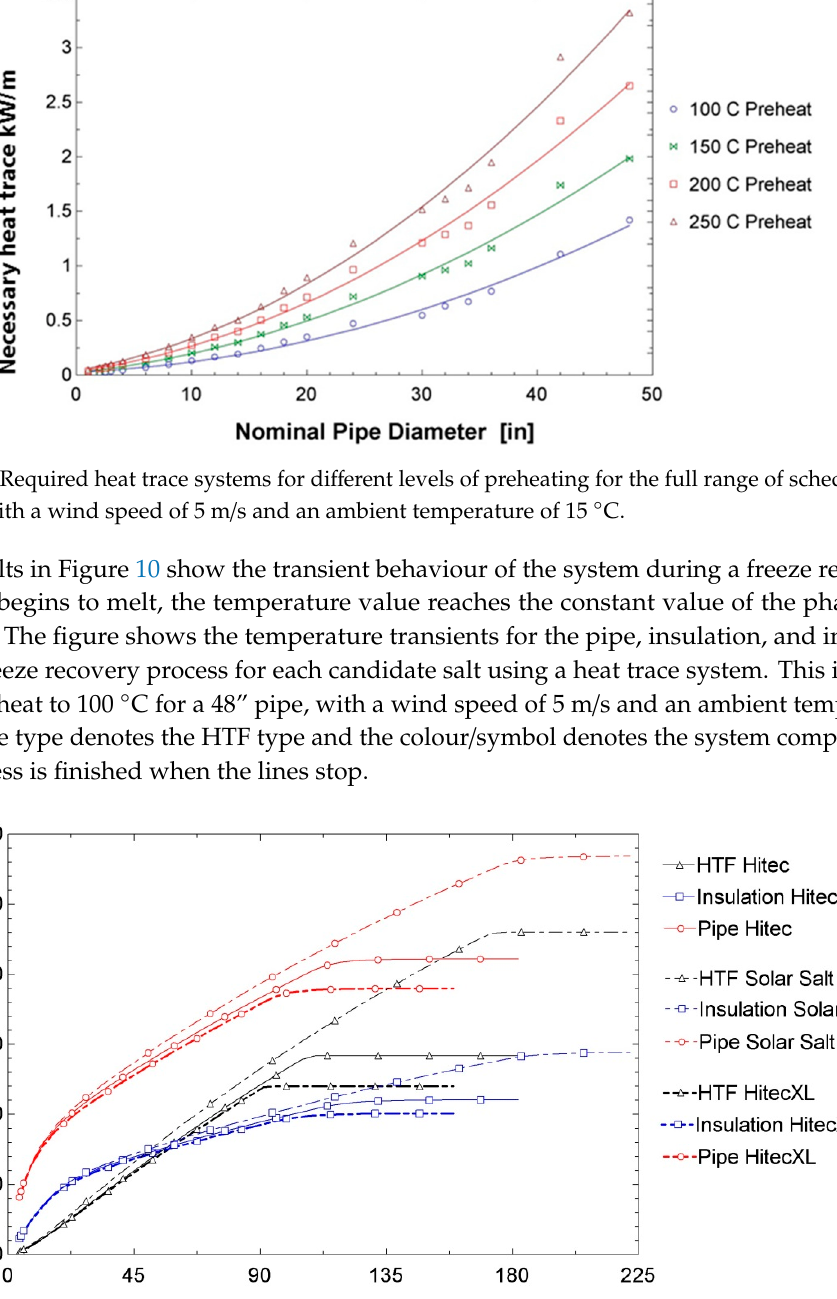
Figure 11. Effect of initial preheating temperature on melting time and the heat trace rating for a system with a 48” pipe using Solar Salt. The results in Tables 2–5 show that HiTec and Solar Salt both require 141,892 m of heat trace cable, while HiTec XL requires 143,592 m. The values for HiTec and Solar Salt are the same because the heat trace cables come in discrete numbers and rounding causes the slight difference in required power to be lost. HiTec XL heat trace system requirements are larger because the pipe sizes for a HiTec XL based system were found to be slightly larger than the other two salts. Heat trace system sizes are a function of the pipe sizes and the HTF properties, but, because pipe sizes are only a function of HTF properties, the heat trace system size can also be considered a function of HTF properties.